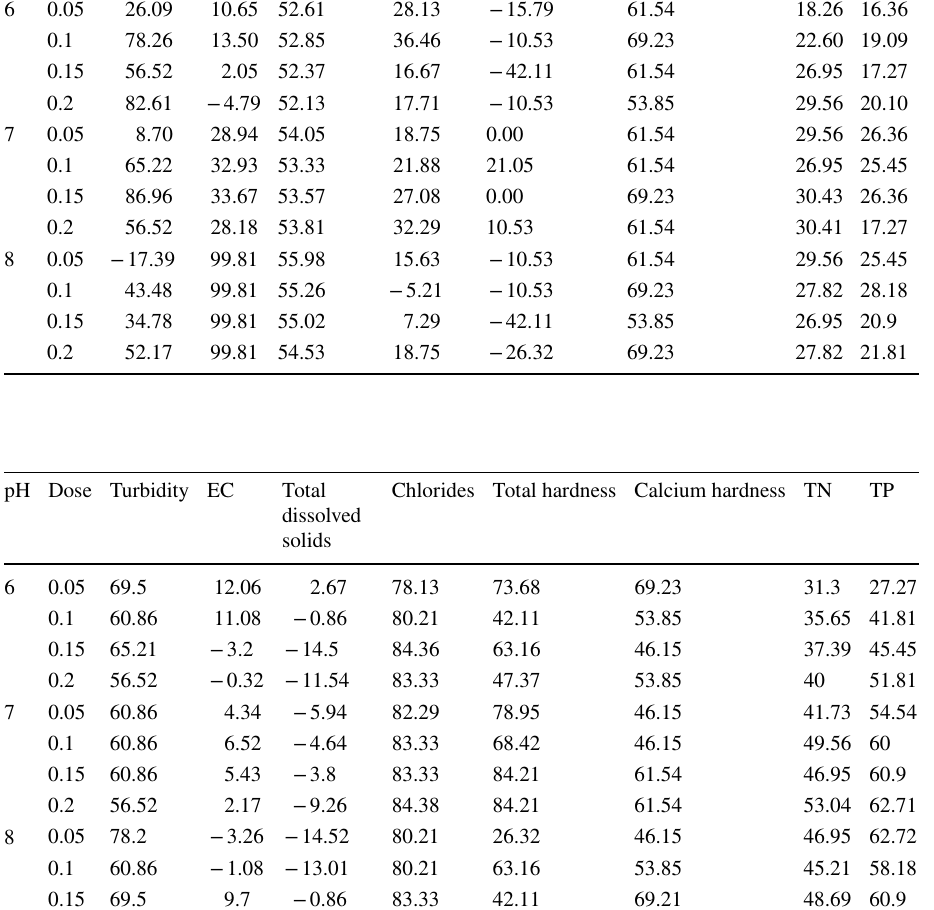
in physicochemical parameters after treating with ferric